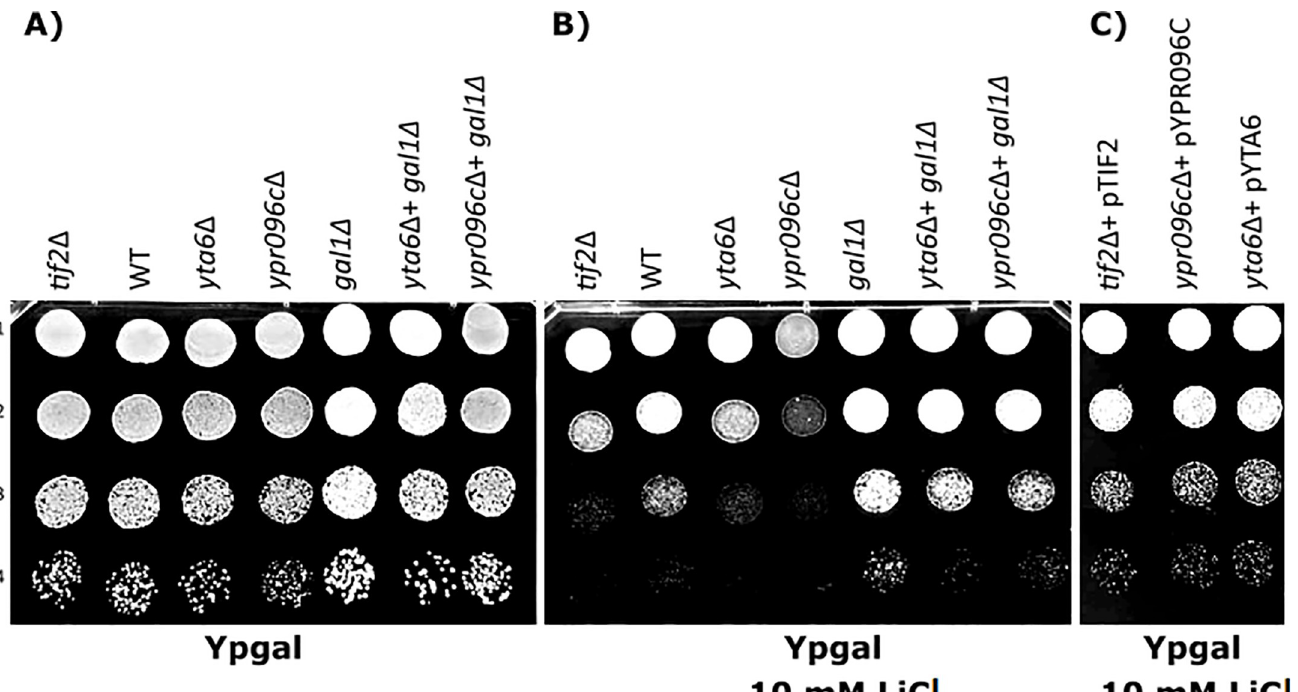
PLOS ONE | https://doi.org/10.1371/journal.pone.0235033 July 8,